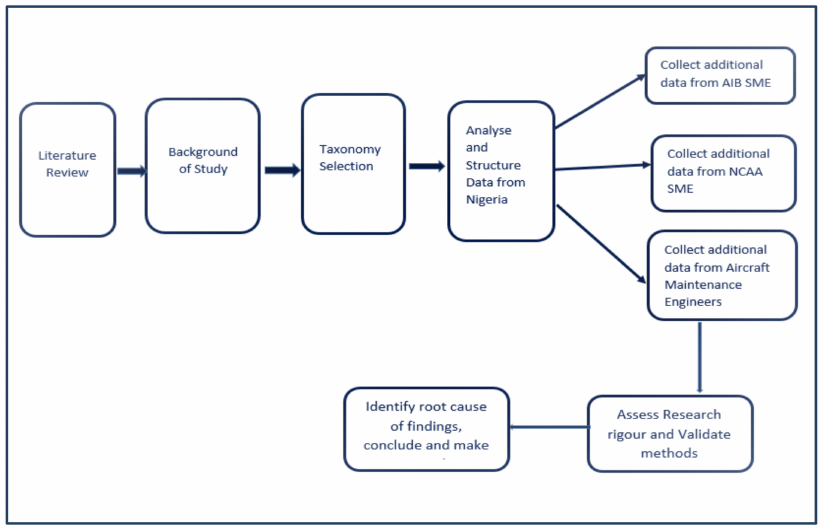
Figure 1. Research